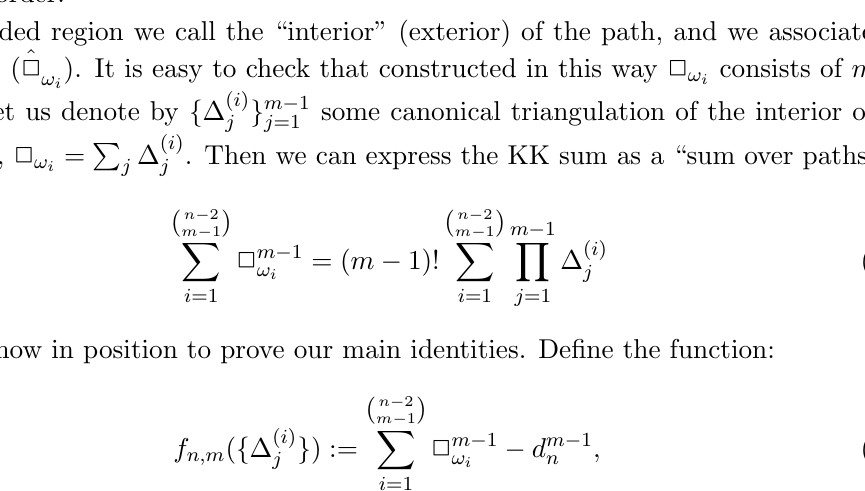
+ ^ 2 ! = 2 + ^ 2 and d ! i i